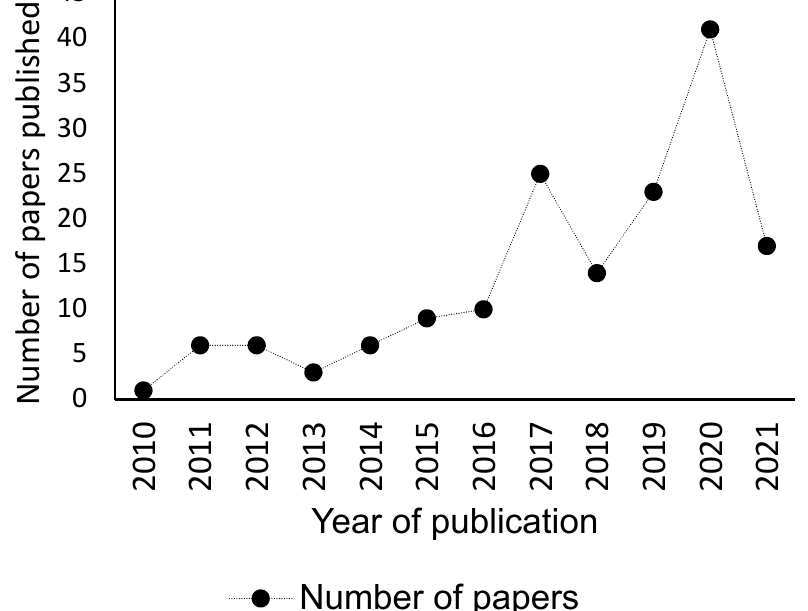
Figure 1. Number of papers per year included in the Web of Science database ( n = 161).